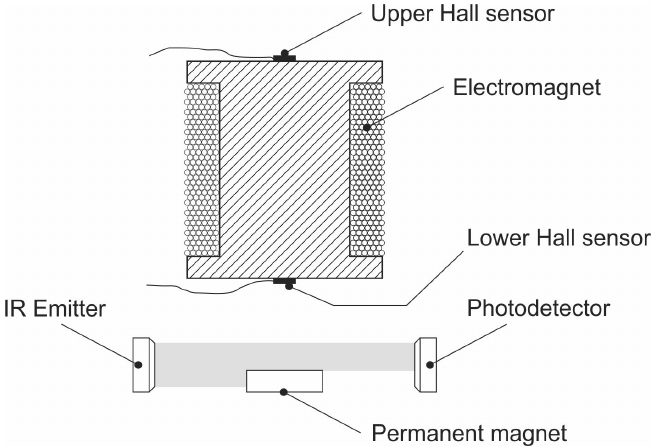
Figure 8. Possible sensors for detecting position of the permanent